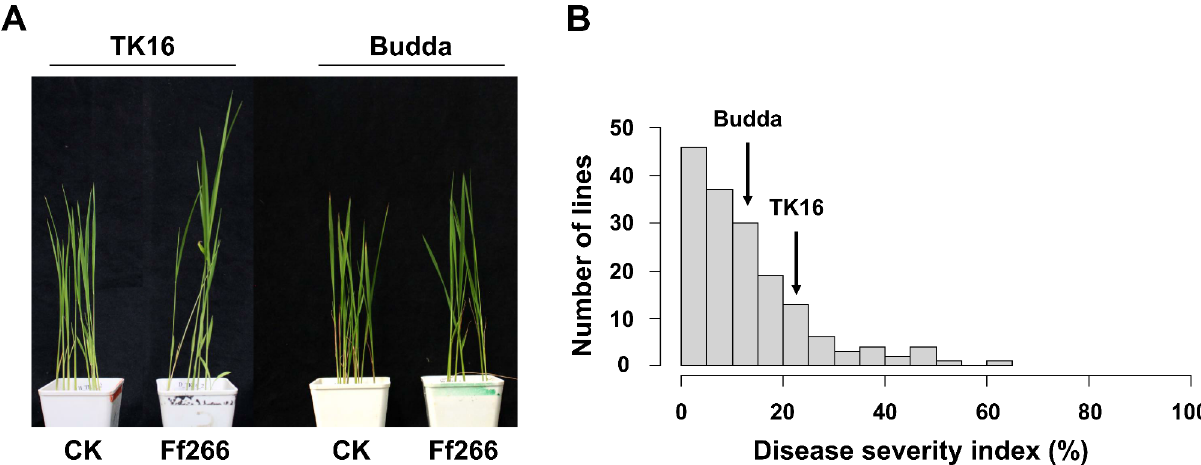
Fig. 1 Bakanae resistance of ‘TK16’, ‘Budda’, and the derived recombinant inbred lines (RILs). A , Symptoms of ‘TK16’ and ‘Budda’ inoculated with Fusarium fujikuroi Ff266 at 21 days post-inoculation. B , Frequency distribution for disease severity index in the RIL population derived from ‘TK16’ × ‘Budda’. The ar- rows indicate the means of disease severity index (DSI) of ‘TK16’ and